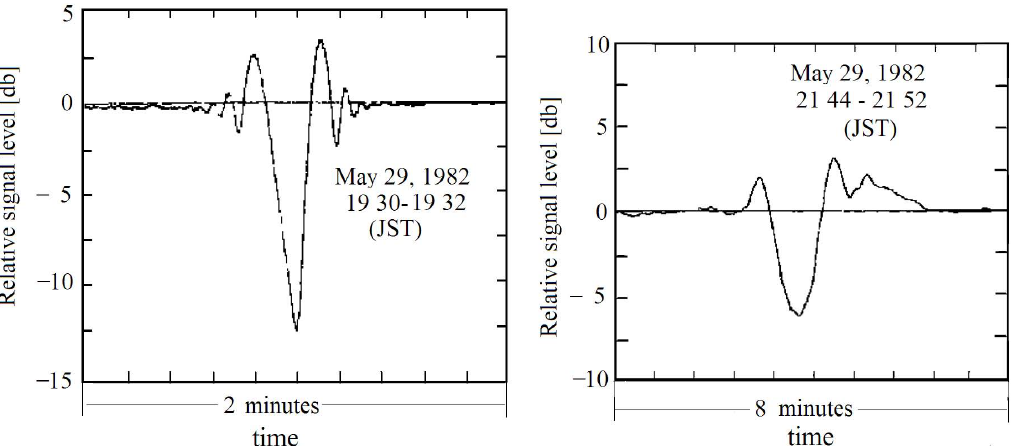
Fig. 6. Two examples of S-type variations of the relative signal level in the trans-ionospheric geostationary satellite-Earth communication link at frequency of 1.5415GHz (Karasawa et al.,